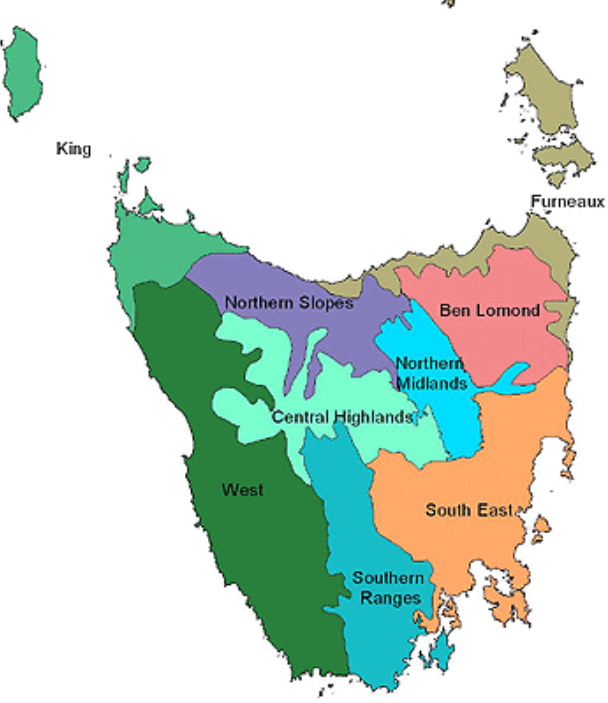
Figure 1. Nine bio-regions of Tasmania. Sourced from the work in